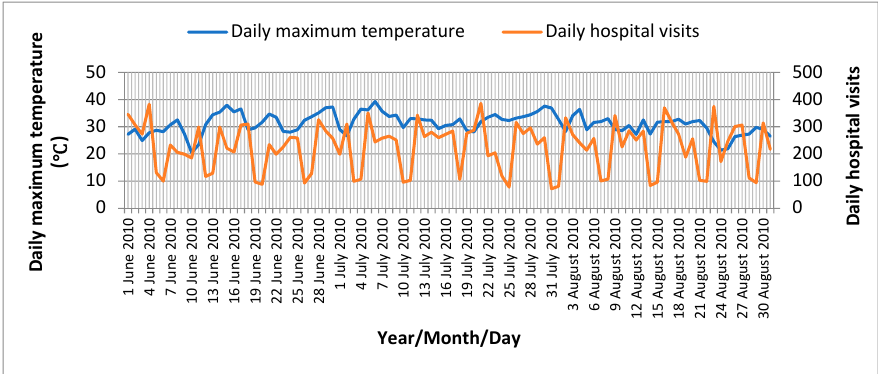
Figure 1. Daily maximum temperature and daily hospital visits in the study period of 2010 in Jinan. Table 3. Description of daily mental illness cases and meteorological factors during the study period.